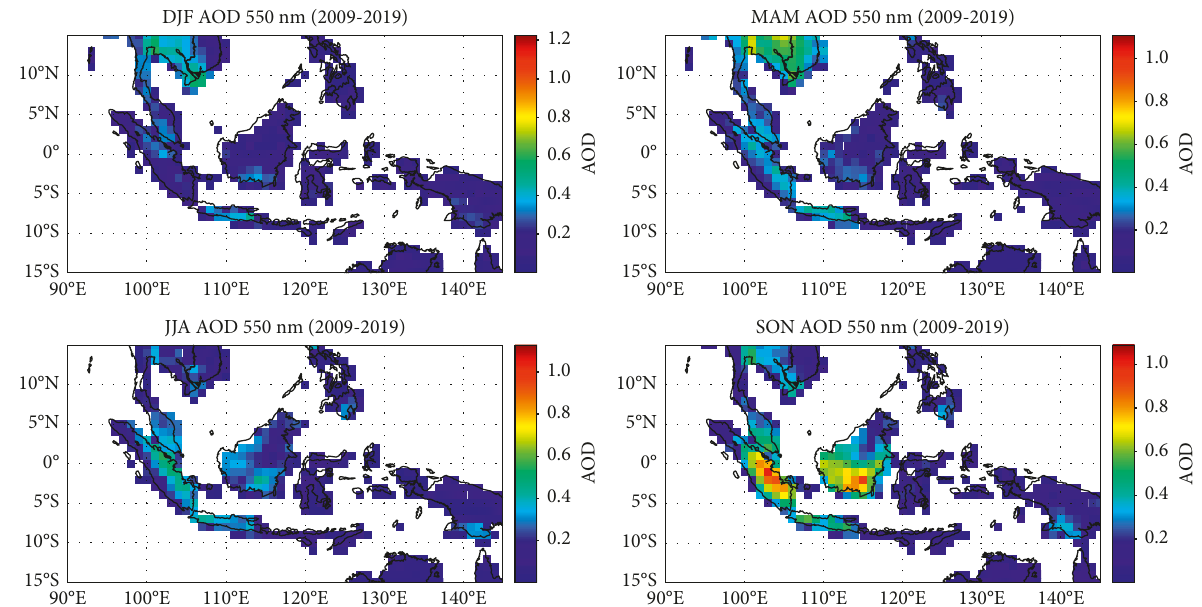
Figure 7: The spatial and seasonal variation of the annual mean MODIS DB C6.1 AOD at 550nm over land in Indonesia during the period 2009 to 2019.